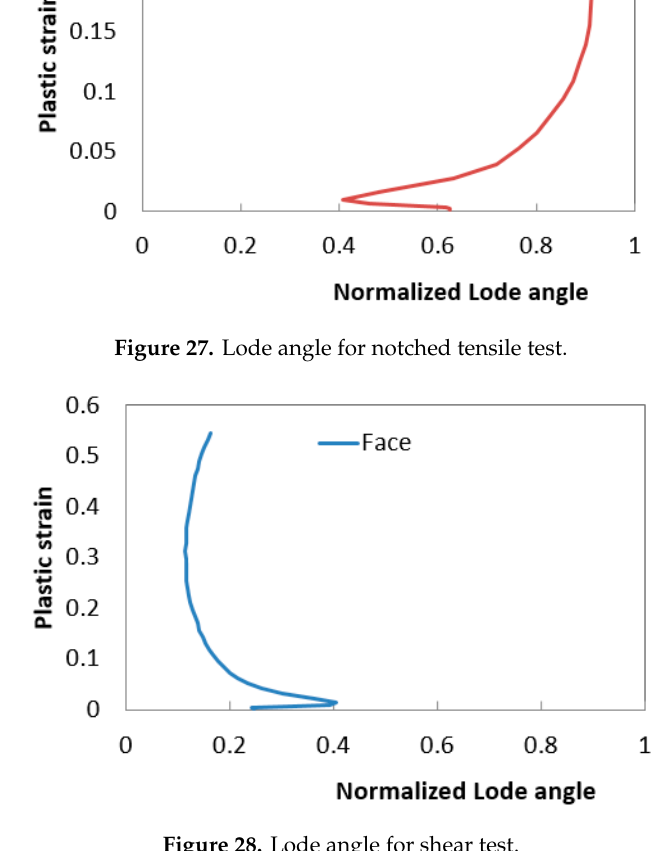
Figure 28. Lode angle for shear test.